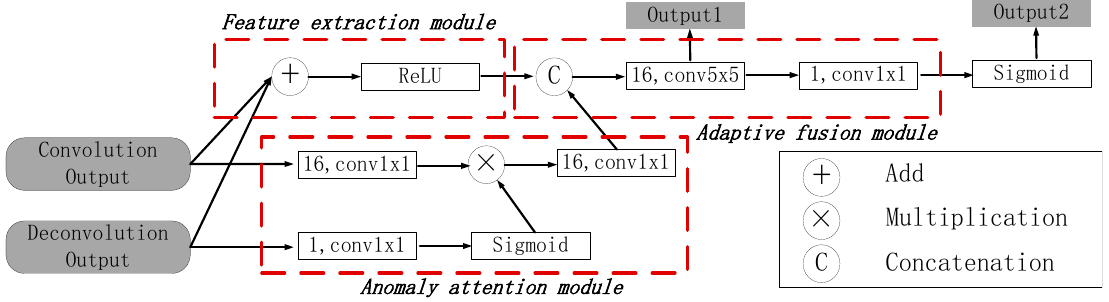
Figure 2. Attention-based fusion Figure 2. Attention ‐ based fusion module. Figure 2. Attention ‐ based fusion module.